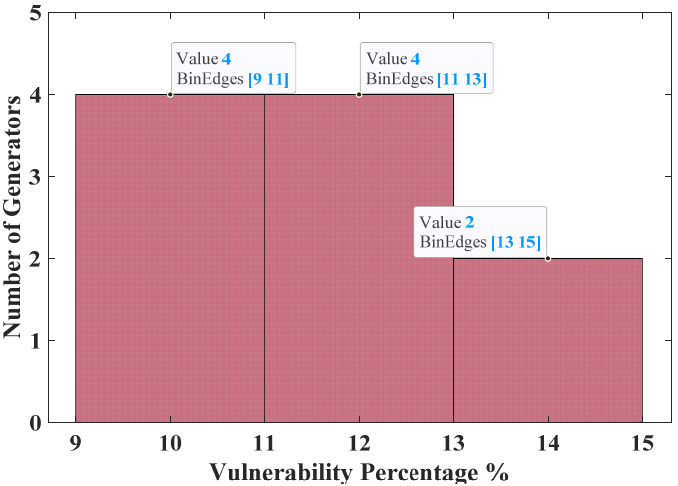
Figure 5. The vulnerability analysis of the generators for strategy 2.